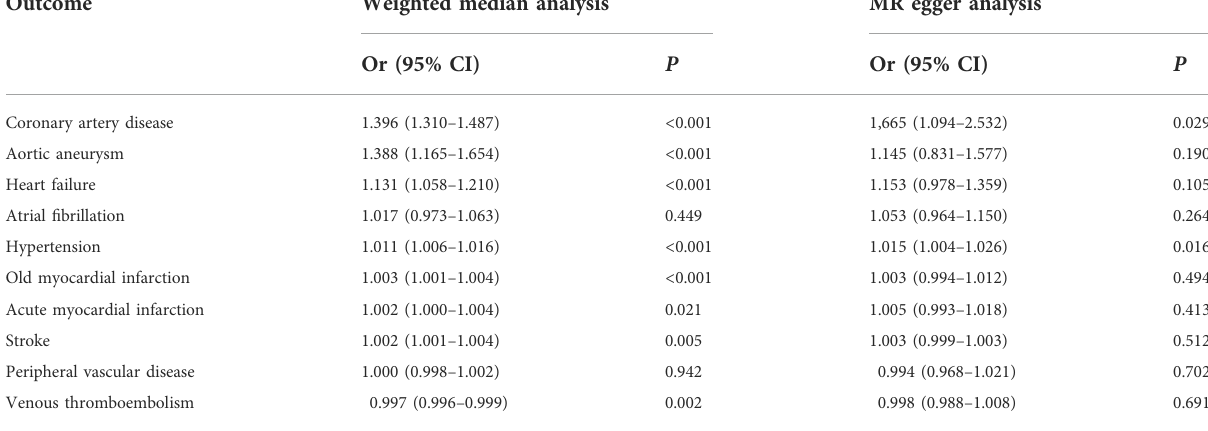
TABLE 3 The results of sensitive analysis by the weighted median and MR Egger